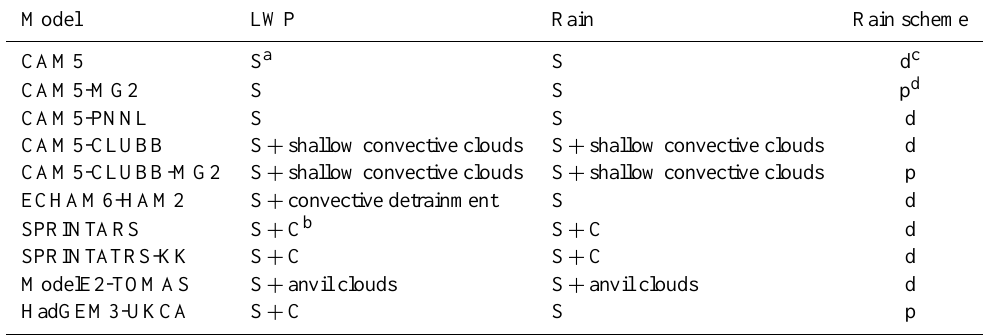
Table 1. The types of clouds included in liquid water path (LWP) and surface rain rate and different rain schemes in 10 participating models Model LWP Rain Rain scheme CAM5 S a S d c CAM5-MG2 S S p d CAM5-PNNL S S d CAM5-CLUBB S + shallow convective clouds S + shallow convective clouds d CAM5-CLUBB-MG2 S + shallow convective clouds S + shallow convective clouds p ECHAM6-HAM2 S + convective detrainment S d SPRINTARS S + C b S + C d SPRINTATRS-KK S + C S + C d ModelE2-TOMAS S + anvil clouds S + anvil clouds d HadGEM3-UKCA S + C S